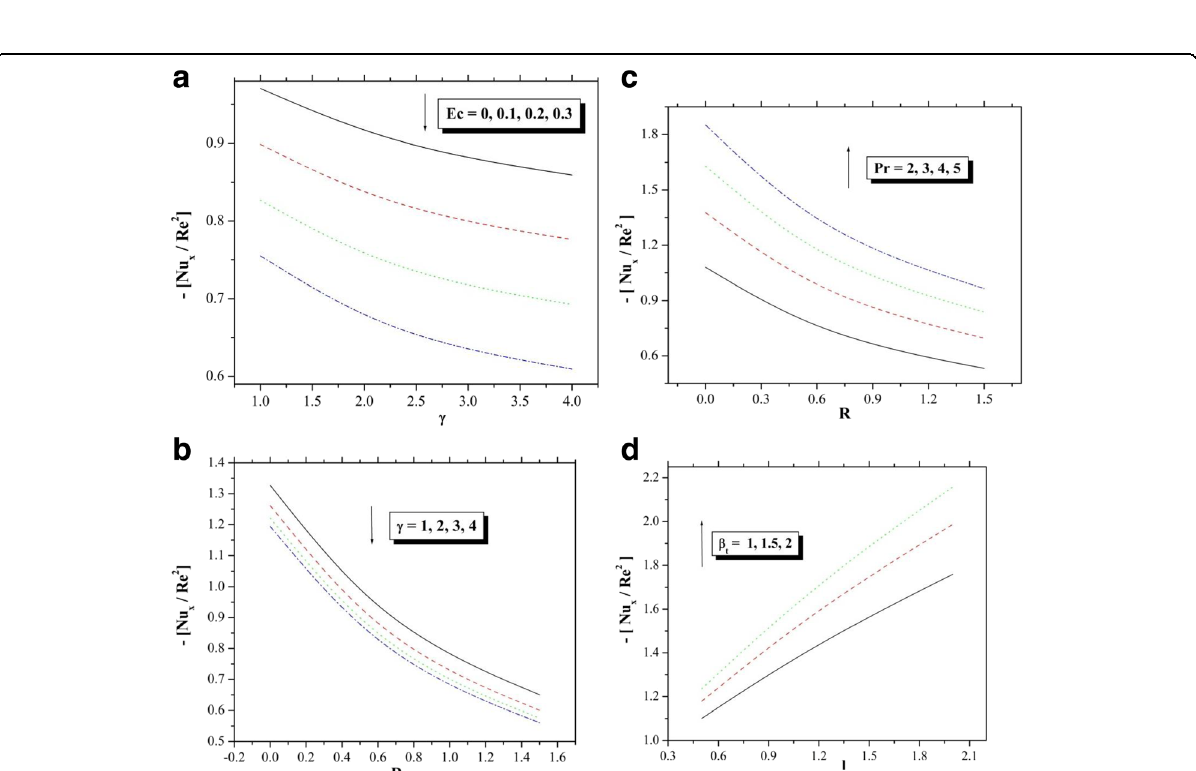
Fig. 10 a Influence of Ec and γ on Nusselt number. b Influence of R and γ on Nusselt number. c Influence of R and Pr on Nusselt number. d Influence of l and β t on Nusselt